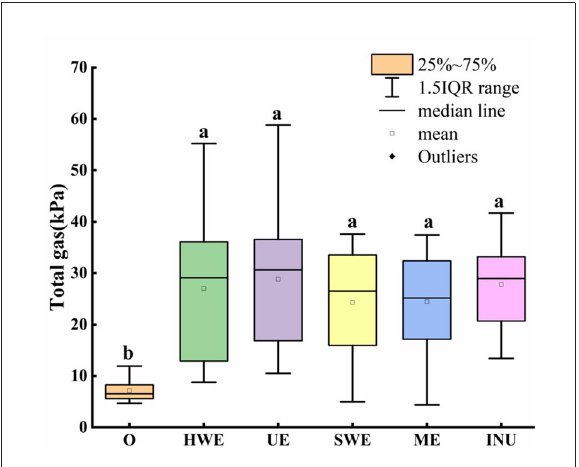
FIGURE2 Gas production of in vitro fermentation samples. O stands for blank control group. HWE, UE, SWE, and ME stand for dietary fiber extracted with hot water, ultrasonic assisted, subcritical water, and microwave assisted methods, respectively. INU stands for inulin. Different letters a and b indicate significant differences (p < 0.05), the same letters indicate that the differences are not significant ( p >